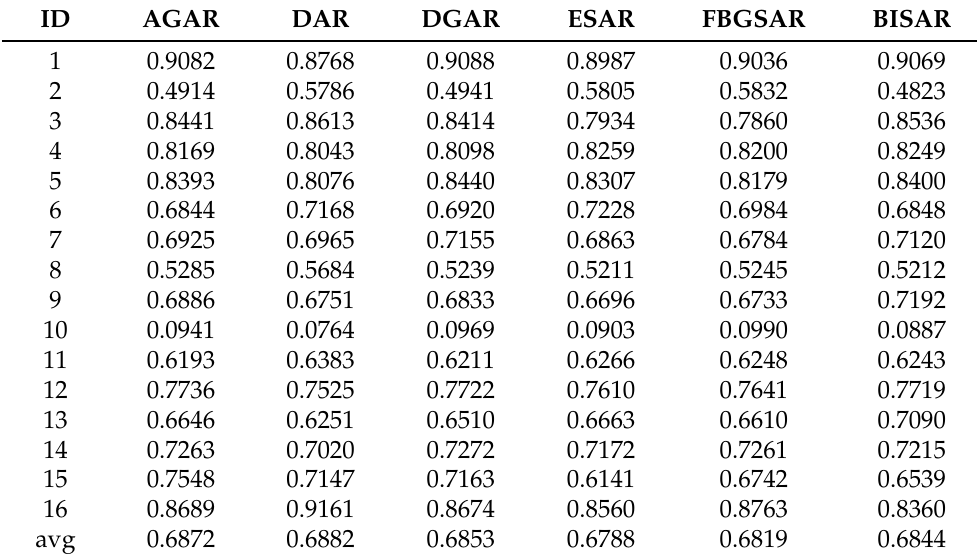
Table 9. Classification accuracies based on the KNN classifier (label